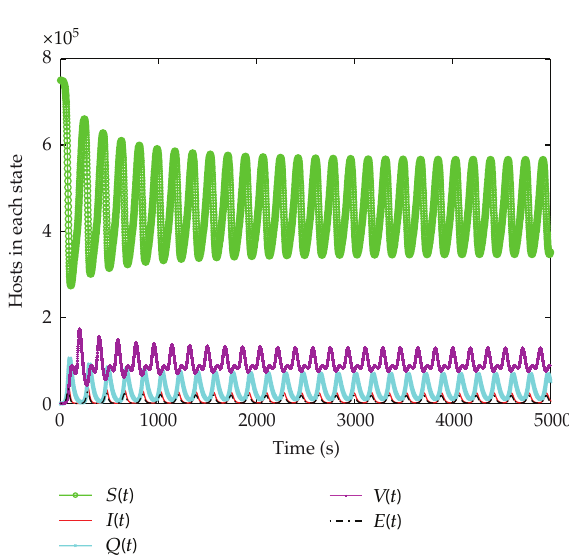
Figure 4: Propagation trend of the five kinds of host when τ > τ 0 .